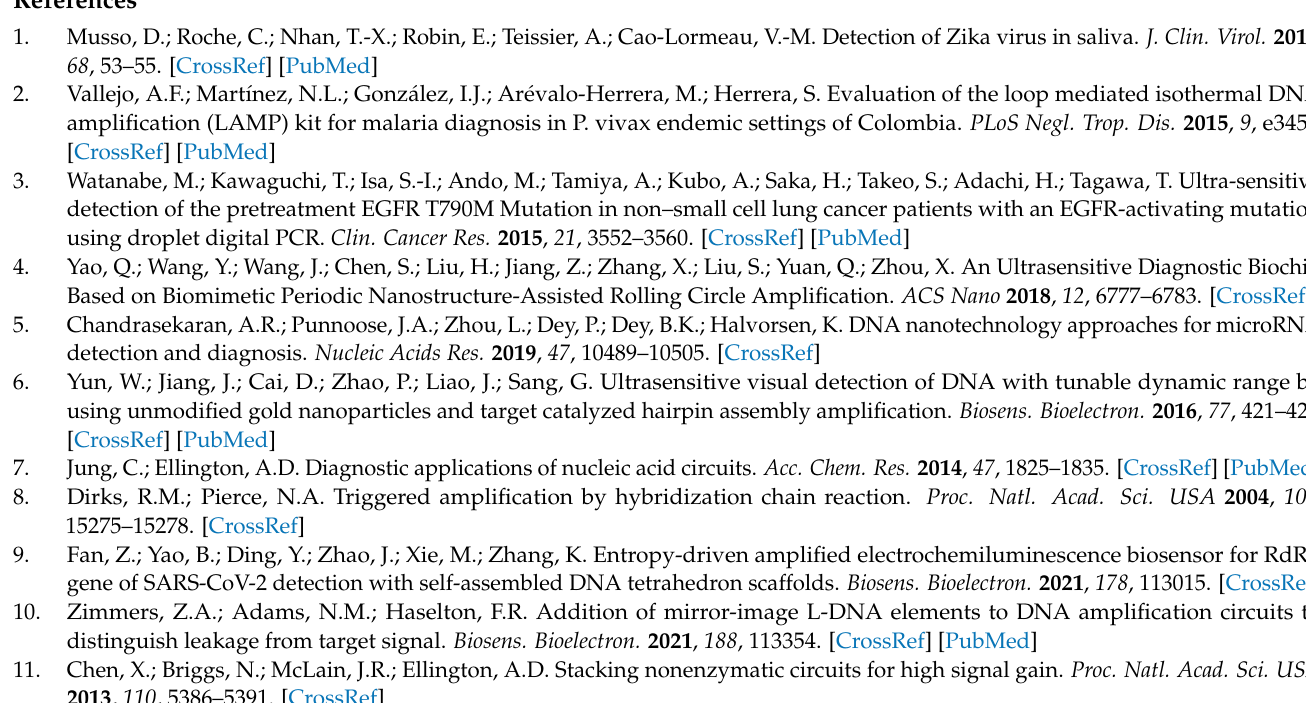
formation with varying U2-a U2-b ratios. Figure S4: Gel electrophoresis results for L-DNA dumbbell binding studies. Figure S5: Microscopic images of magnetic beads bound with fluorescently-labeled DNA. Figure S6: The effect of magnetic beads on fluorescence measurements. Figure S7: Overview of the TMSD strategy to remove DNA from magnetic beads. Figure S8: Comparison of different strategies to remove DNA from magnetic beads. Figure S9: Comparison of different bead blocking protocols effect on non-specific binding and amplification. Figure S10: The effect of dumbbell incubation time on signal